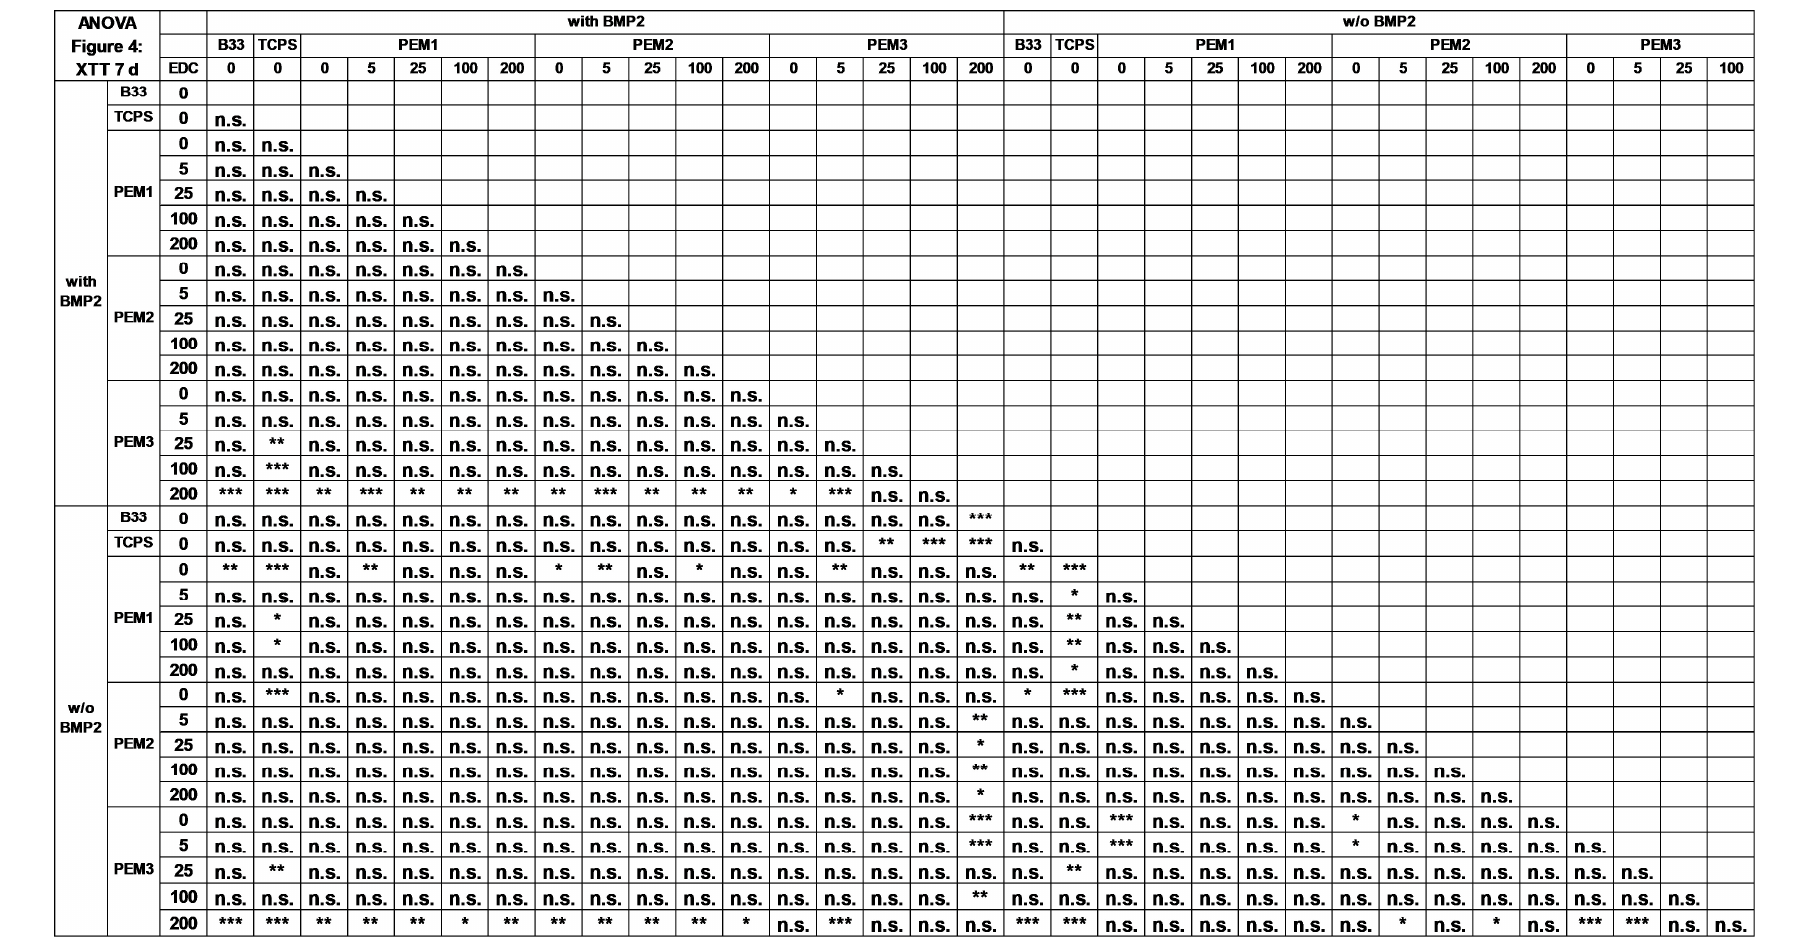
Figure A4. Results of one-way ANOVA for data related to Figure 4 (7 d); n.s.: not significant; *: p < 0.1; **: p < 0.05; ***: p < 0.001.